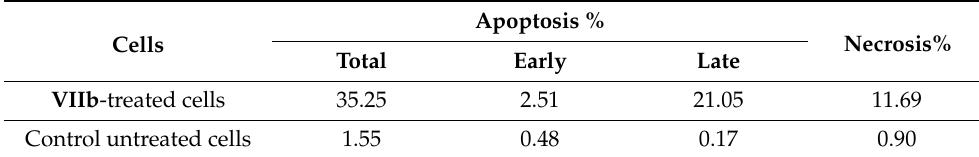
Figure 4. The cell distribution in cell cycle phases following Compound VIIb exposure.